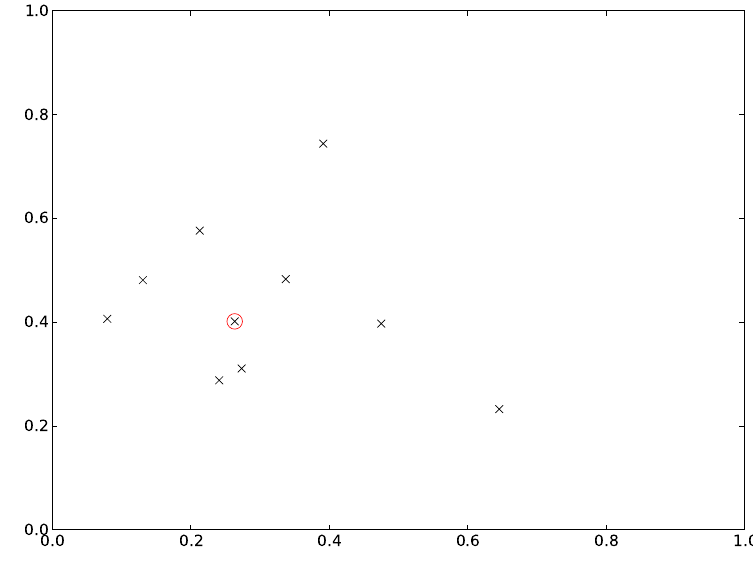
Figure 1. Illustrative example of medoid selection in a 2-dimensional space. The medoid, as selected by Equation (1), is circled in red. The data is randomly generated, purely to illustrate the medoid